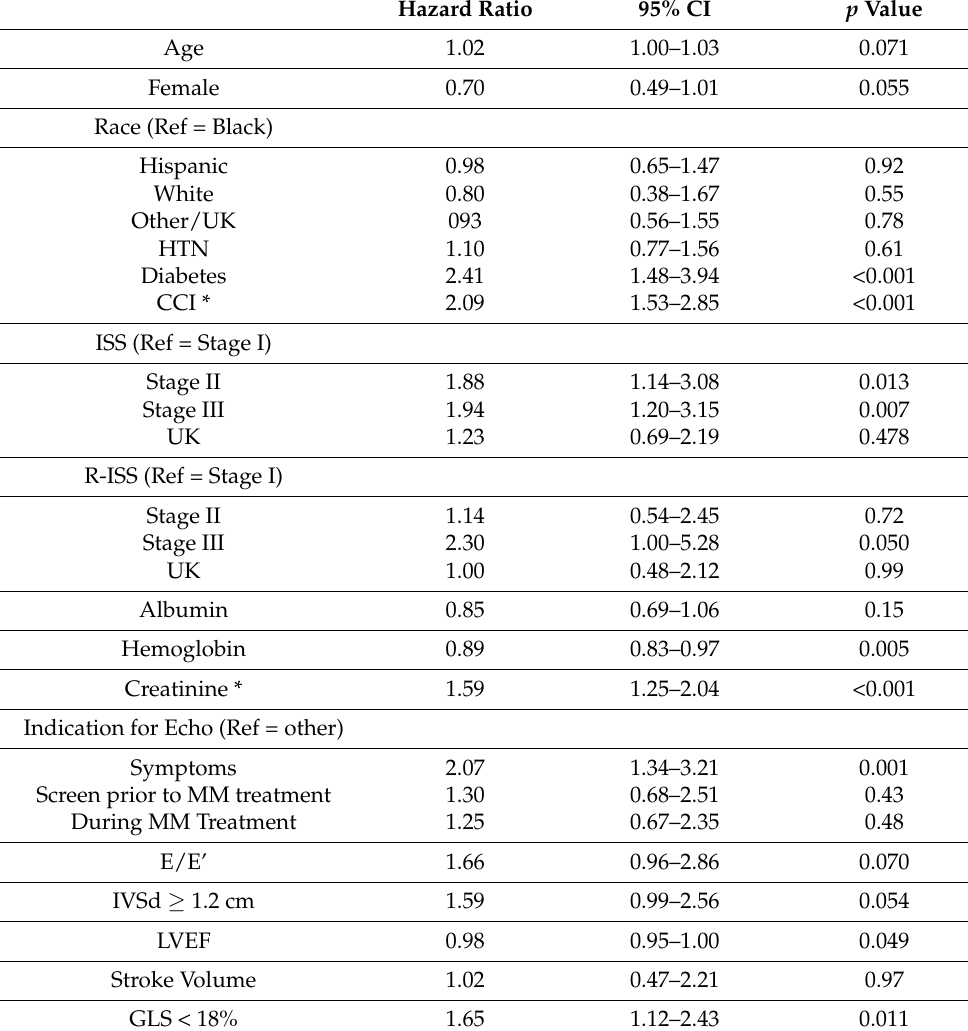
Table 3. Univariable analysis of baseline variables and OS.